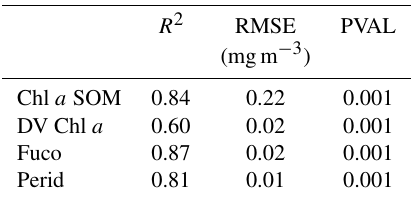
Table 2. Statistical parameters ( R 2 coefficients, RMSE and P val- ues) of the cross-validation between the DPIG in situ pigments and the pigments given by the 2S-SOM averaged for the 30 2S-SOM